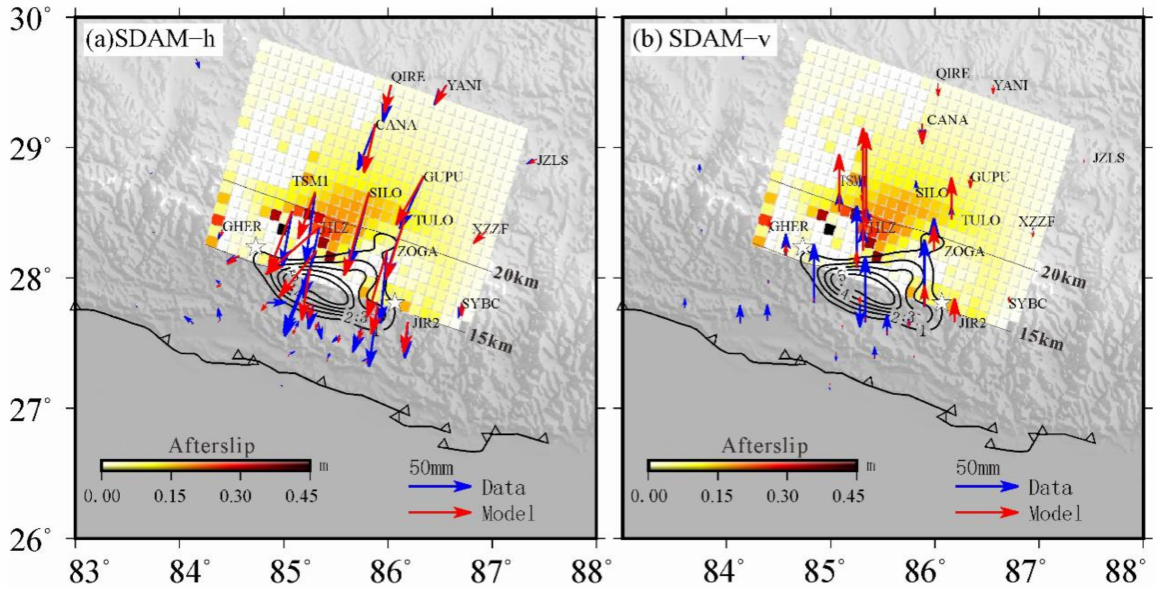
Figure 13. Simulated stress-driven afterslip in one year after the Nepal Mw 7.8 earthquake; ( a ) vectors are GPS observed (blue) and predicted (red) horizontal motion values; dotted lines and contours indicate fault depth and co-seismic slip on the fault plane; ( b ) vectors are GPS observed (blue) and predicted (red) vertical motion